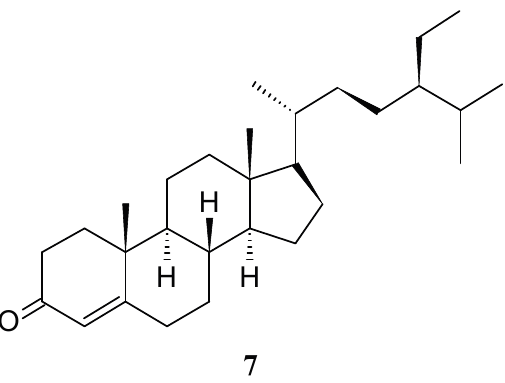
Figure 1. Structures of alkaloids 1 – 7 isolated from the roots of M. compressa var. lanyuensis.